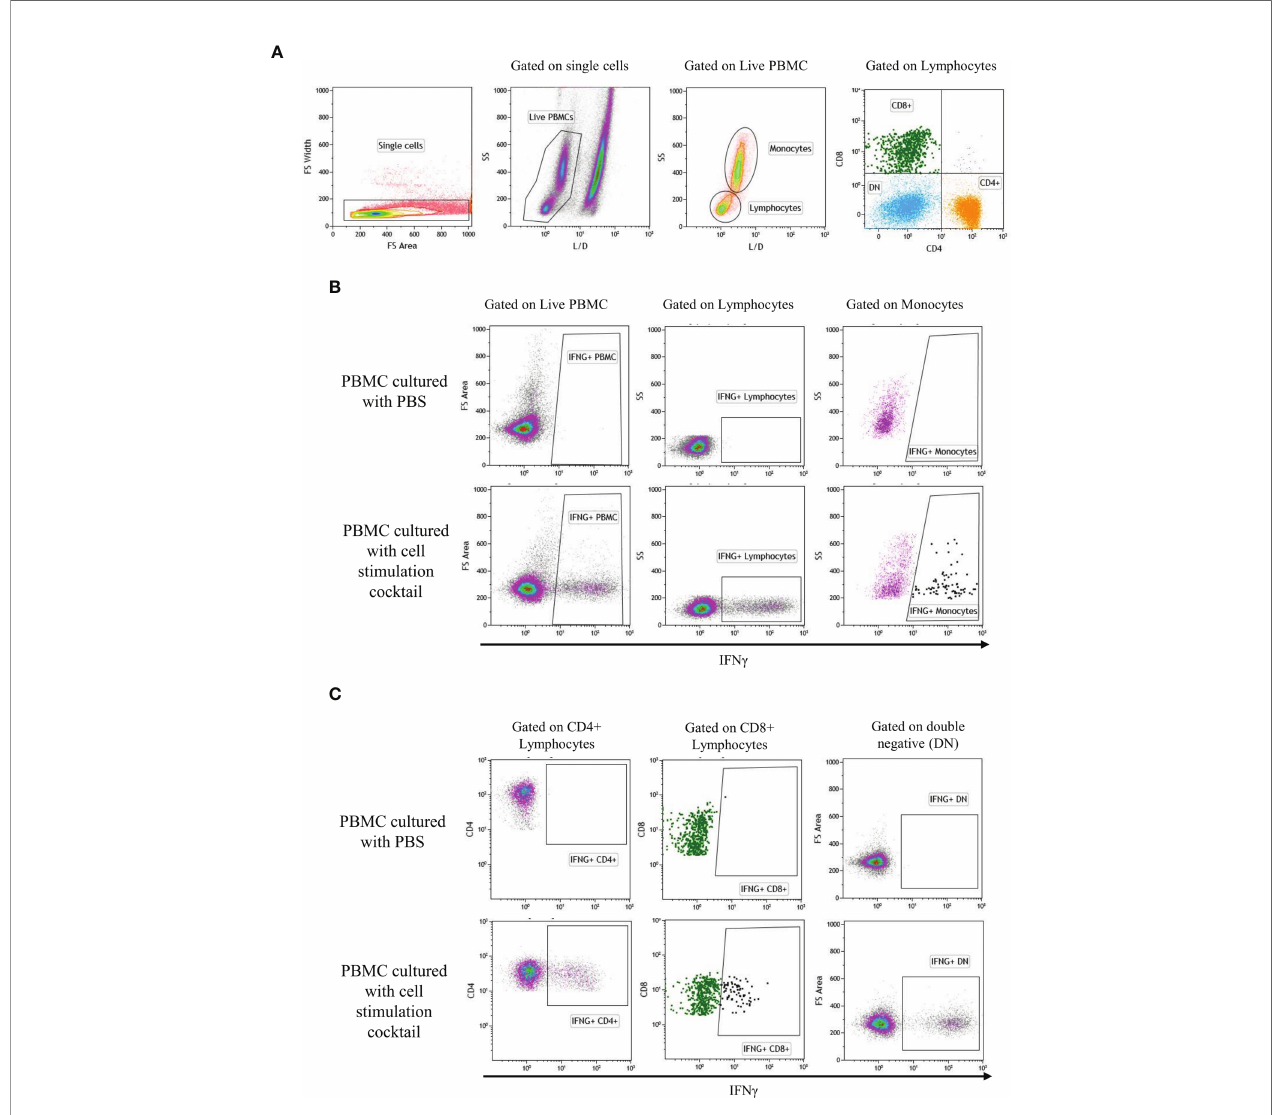
FIGURE 1 | Gate represents gating strategy for Flow cytometry. Analytic gating of fl ow cytometry showed a representative graph of the change in the mean fl uorescence intensity of IFN g in the PBMC subpopulation. (A) Single cells were selected in the forward scatter-height (FSC-HA) versus forwarding scatter-width (FSC-WA) plot, then, live/dead was gated to identify live cells. Next, monocytes and lymphocytes were gated from the live cells on FSC-A versus SSC-A plot. Gating of lymphocyte subset was performed as CD4 + , CD8 + , and CD4/CD8 double-negative (DN). (B) Expression of IFN g by PBMC, monocytes, and lymphocytes: IFN g positive populations were gated using PBMC cultured with PBS (negative control) and PBMC cultured with cell stimulation cocktail (positive control). (C) Expression of IFN g by CD4 + , CD8 + , and DN: IFN g positive populations were gated using PBMC cultured with PBS (negative control) and PBMC cultured with cell stimulation cocktail (positive